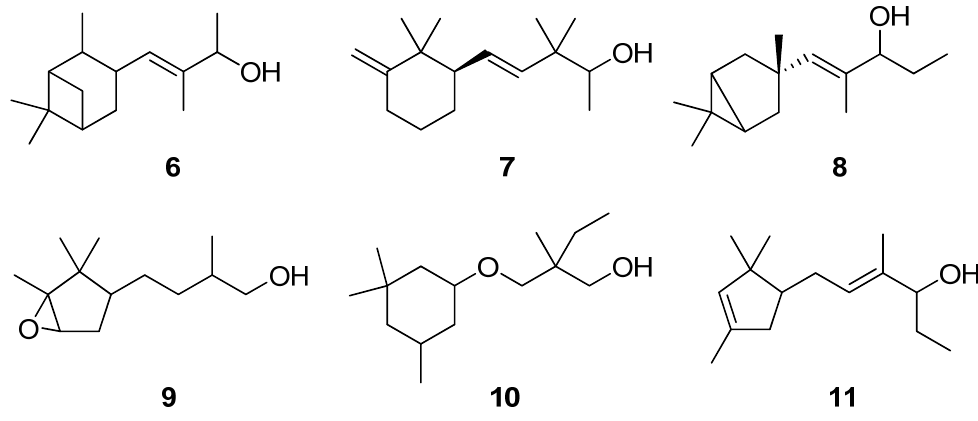
Figure 2. Other sandalwood-type odorants with different bulky moieties.